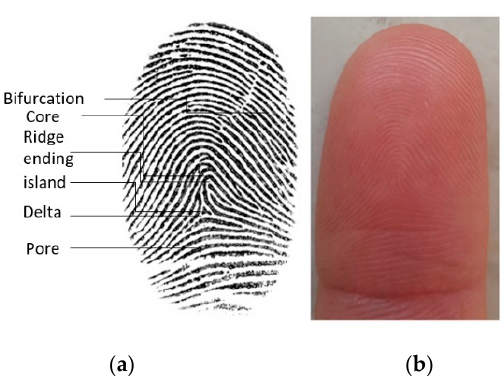
Figure 5. ( a ) Contact-based fingerprint, ( b ) contactless fingerprint (Samsung Galaxy S8) [15].